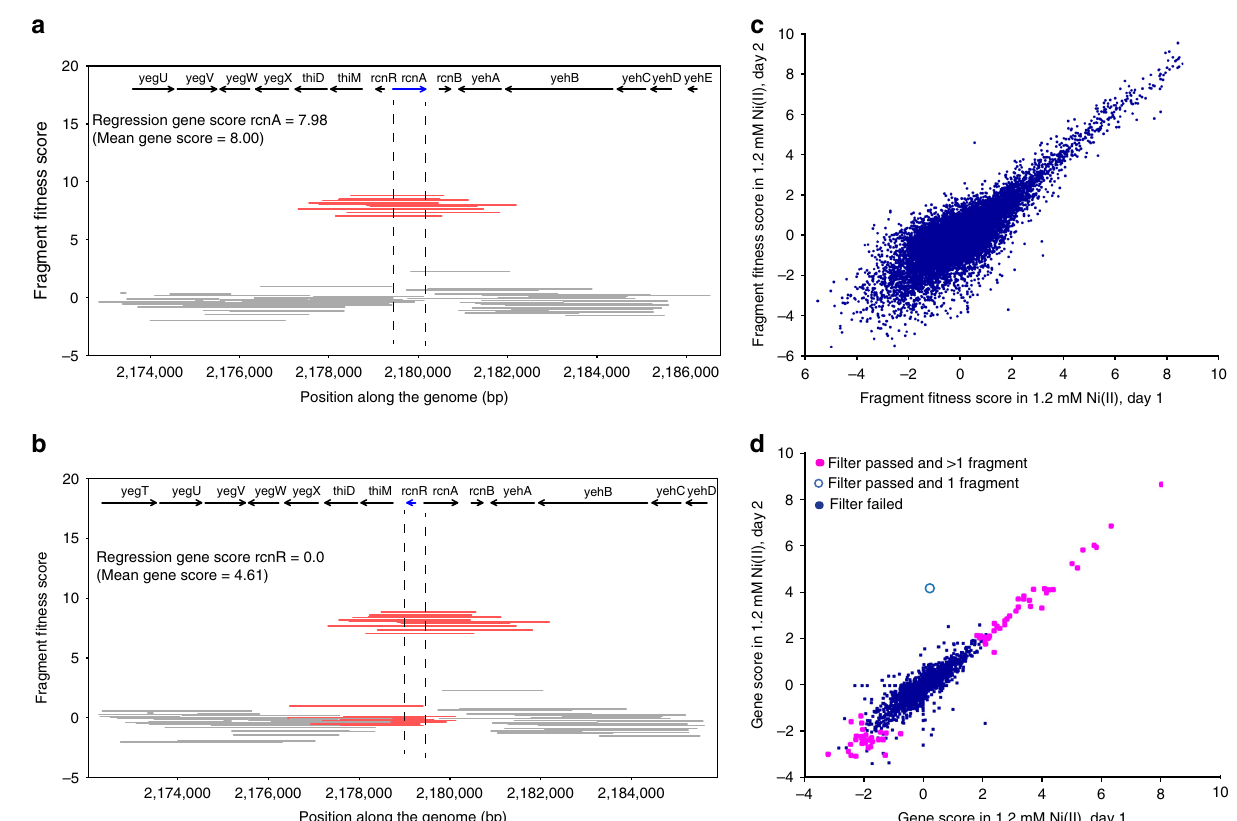
Fig. 3 Fragment and gene fi tness dual-barcoded shotgun expression library sequencing (Dub-seq) scores. a Dub-seq fragment (strain) data for region surrounding rcnA under elevated nickel stress ( y axis). Each line shows a Dub-seq fragment. Those that completely cover rcnA are in red. Both the mean and regression scores re fl ect the known biology of rcnA as a nickel resistance determinant 47 . b Same as ( a ) for the neighboring rcnR , which encodes a transcriptional repressor of rcnA . Fragments that cover rcnR are in red. c Comparison of fragment fi tness scores for two biological replicates of 1.2 mM nickel stress. d Same as ( c ) for gene fi tness scores calculated using the regression approach. Genes are highlighted if their score met our criteria for a high- con fi dence effect within an experiment (without considering other experiments) (see Methods); we also show whether the gene score is based on just one fragment (effects from just one fragment are not considered high con fi dence if they do not replicate). Source data are provided as a Source Data fi